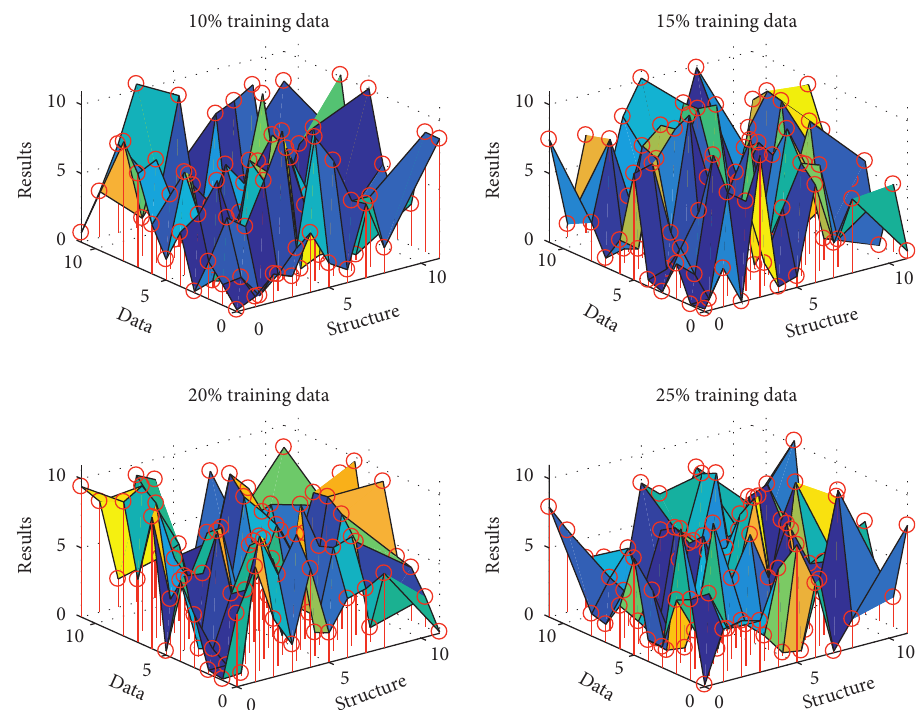
Figure 5: The structure of the improved sequential pattern mining